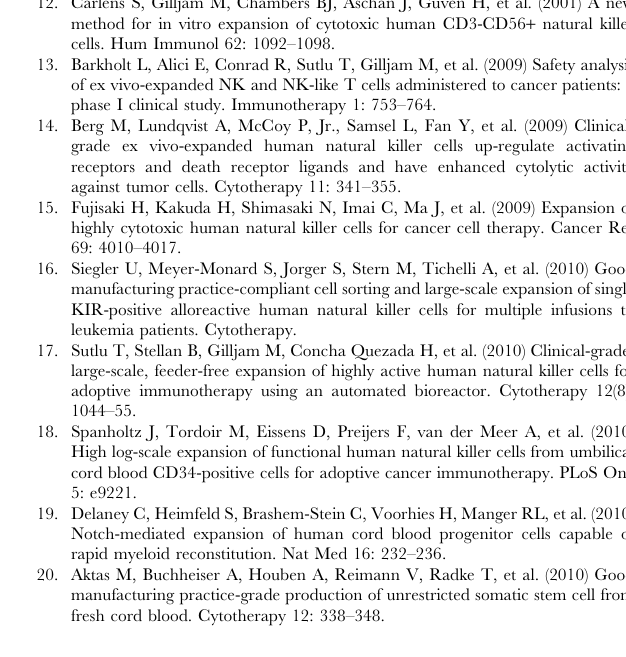
Figure S1 Flow cytometry analysis for phenotype and function of e x vivo expanded NK cells using static bags or bioreactor cultures. ( A ) The CD45 + CD56 + CD3 2 lympho- cytes were analyzed for several NK cell specific surface antigens for bioreactor cultures (black bars) and static bags (grey bars). ( B ) NK cell functionality was tested in a CD107a degranulation assay and the percentage of degranulating cells (CD107 + ) was analyzed.